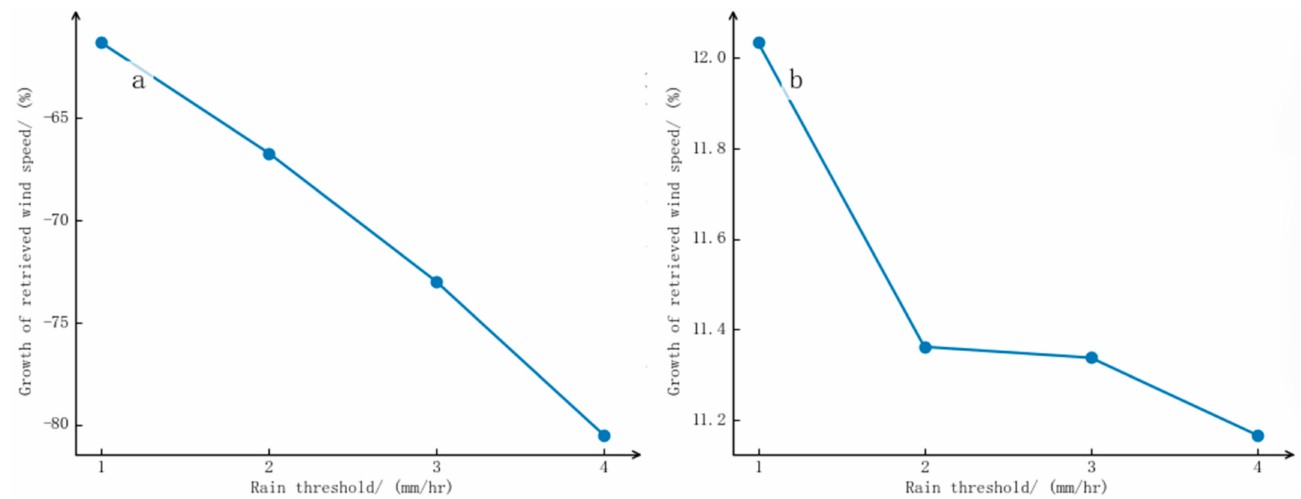
Figure 8. Influence of HY2RRM 0.6 model on accuracy of retrieved wind speed with rain threshold. ( a ) The result of rain-contaminated data; ( b ) the result of rain-free